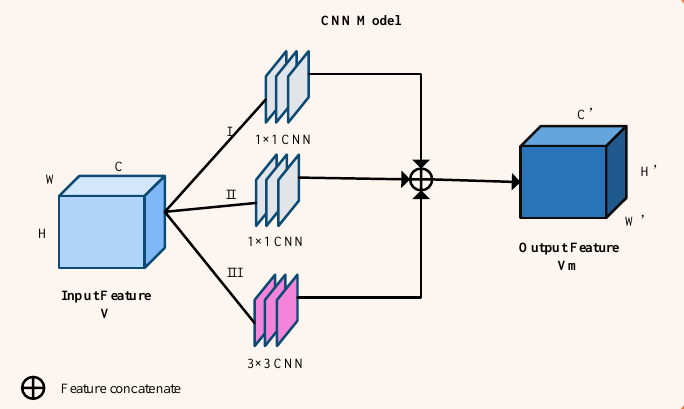
Figure 6. CNN structure.